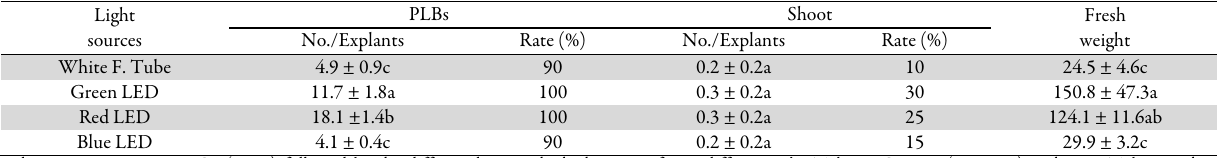
Table 2. In vitro culture of C. devonianum PLBs in modified MS medium supplemented with trehalose (20 g L -1 with modified MS medium) under different sources of lights